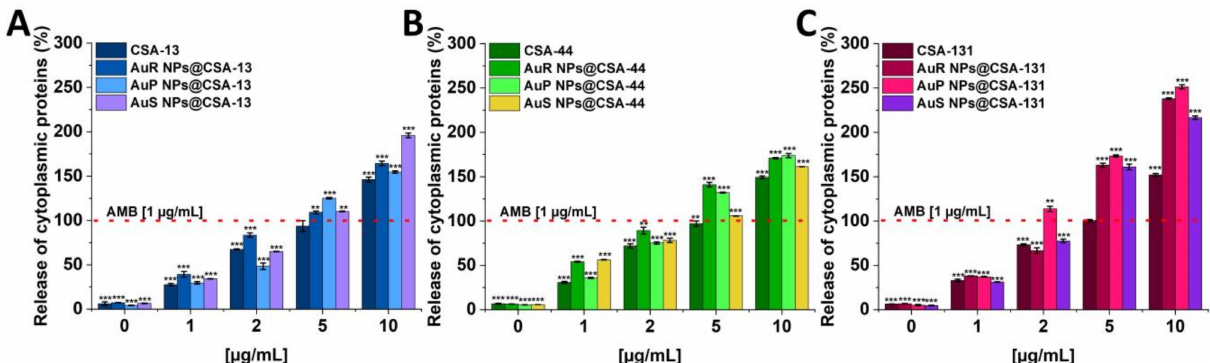
Figure 8. The release of cytoplasmic proteins from C. albicans 1408 after treatment with CSA-13, AuR NPs@CSA-13, AuP NPs@CSA-13, AuS NPs@CSA-13 ( A ); CSA-44, AuR NPs@CSA-44, AuP NPs@CSA-44, AuS NPs@CSA-44 ( B ); and CSA-131, AuR NPs@CSA-131, AuP NPs@CSA-131, AuS NPs@CSA-131 ( C ) at concentrations of 1–10 µ g/mL was evaluated by the Bradford protein assay. The dashed line represents the effect obtained with the amphotericin B at a concentration of 1 µ g/mL. The results show the mean ± SD, n = 3; ** indicates statistical significance at ≤ 0.01, and *** ≤